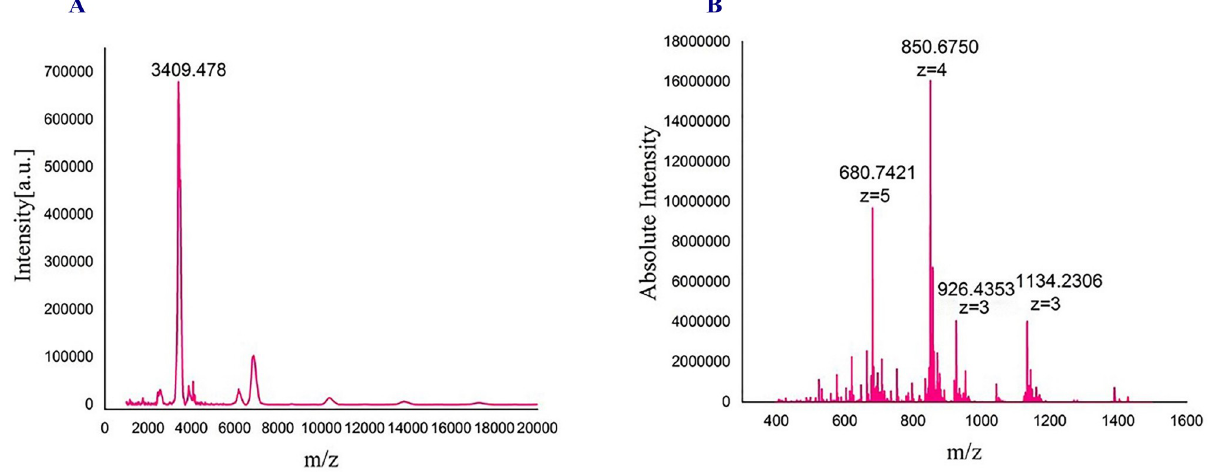
Fig 3. Mass spectroscopy analyses of the LPP. MALDI-TOF mass spectroscopy analysis of the LPP ( A ), and Orbitrap High-resolution Liquid chromatography mass spectrometer analysis of m/z of the peptide ( B ).